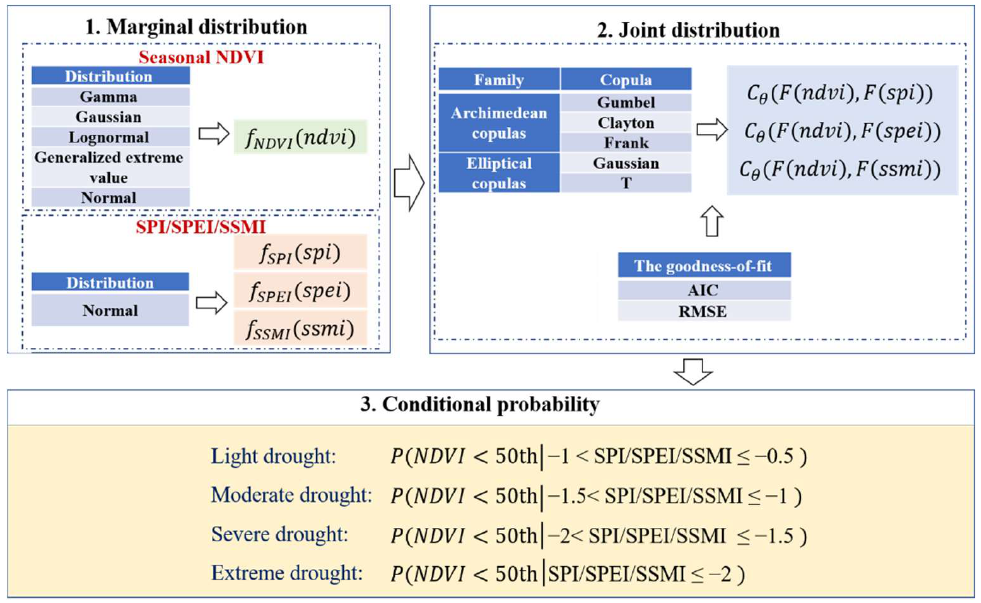
Figure 2. Conditional probability estimation of vegetation decline under multiple drought categories based on copula-based probabilistic framework.